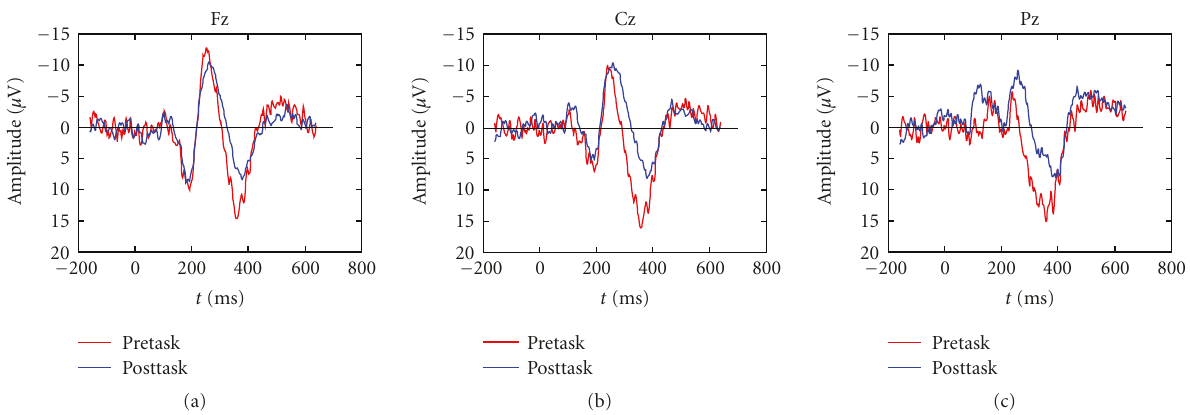
Figure 4: Examples of P300 waveform at electrode locations Fz, Cz, and Pz in the pretask and posttask.